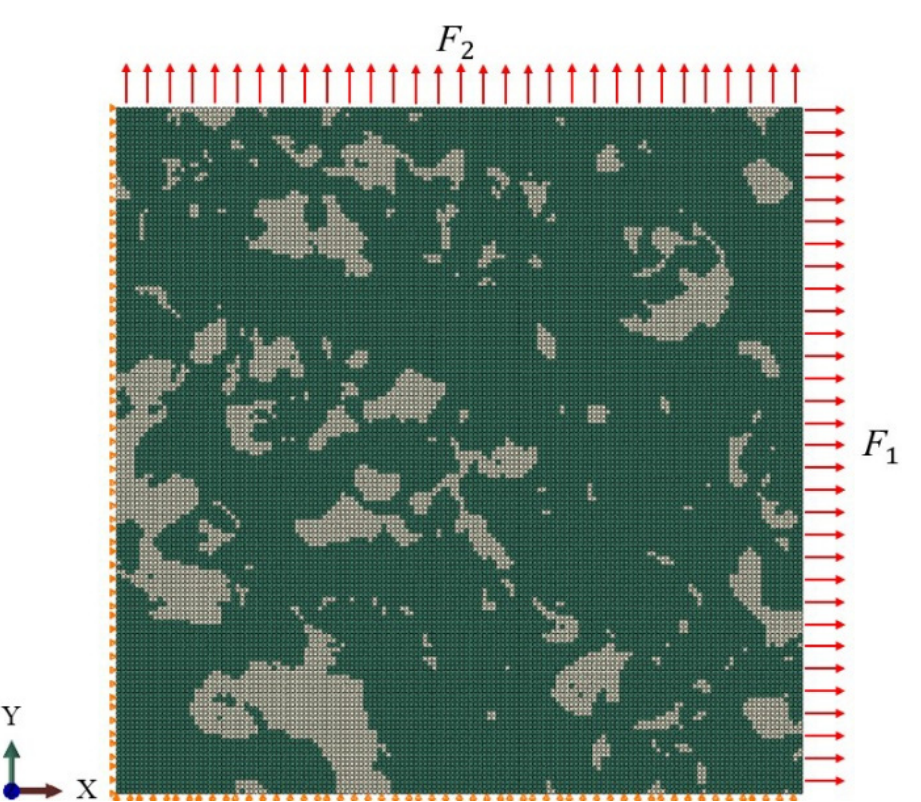
and F were applied on 1 2